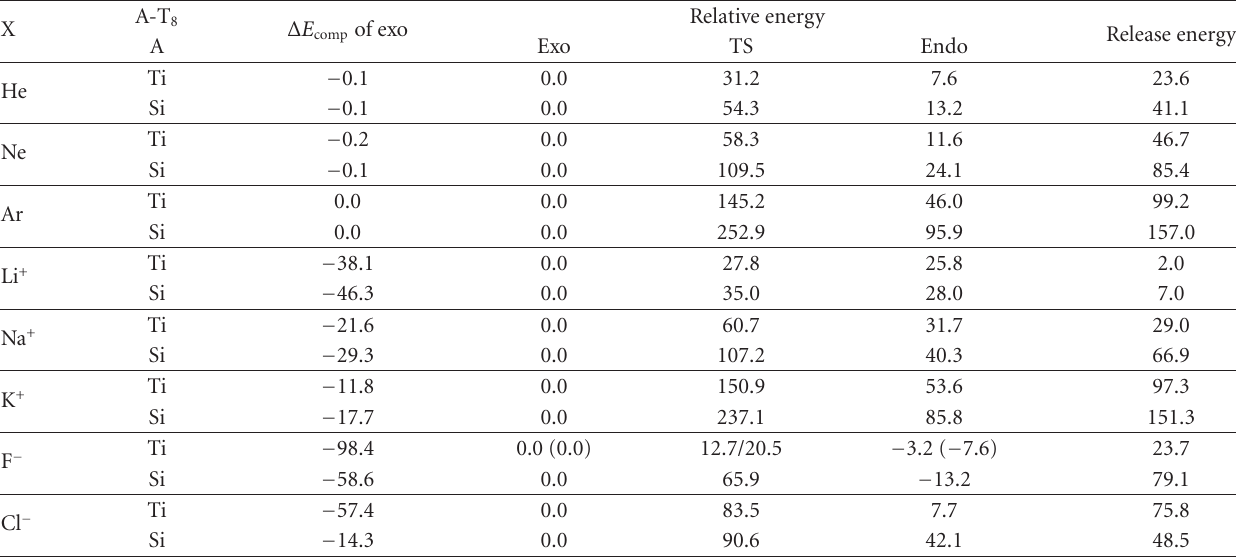
Table 7: The energetics (kcal/mol) of the encapsulation of X (X = He, Ne, Ar, Li + , Na + , K + , F − , and Cl − ) into A-T 8 (A = Si and Ti) at